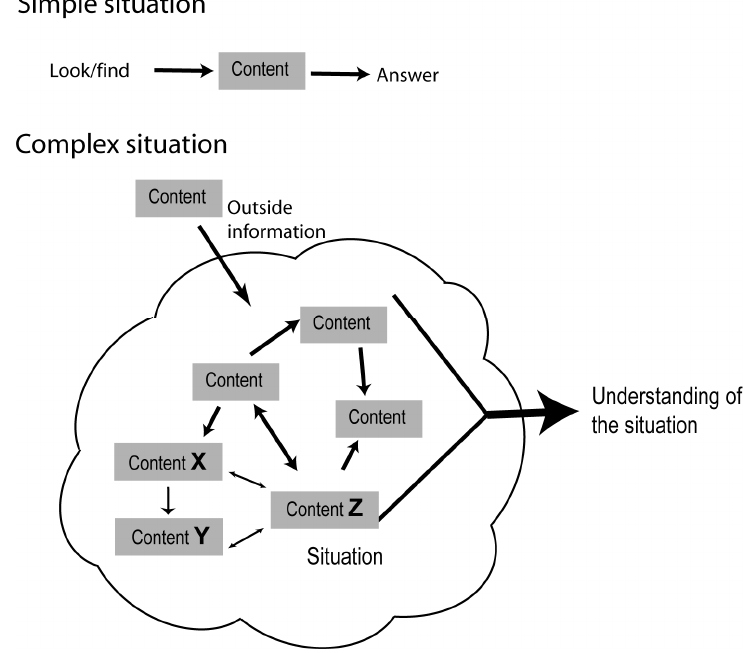
Figure 5. Relationships and understanding a situation.